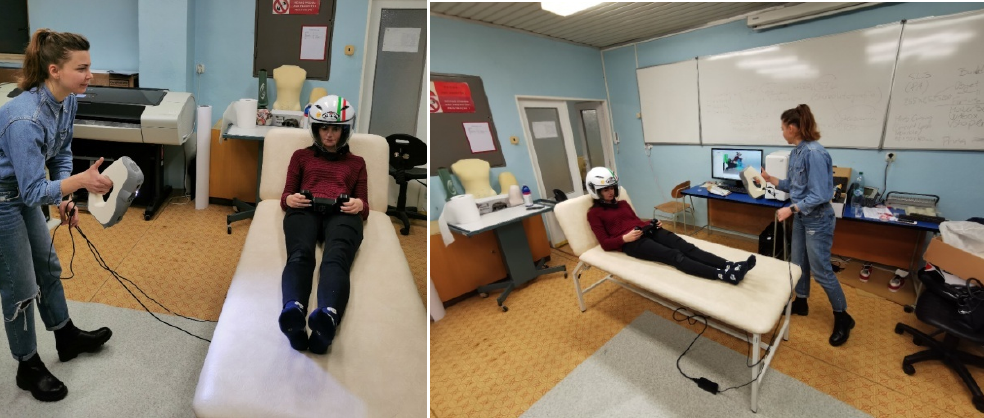
Figure 2. Woman pilot scanning.